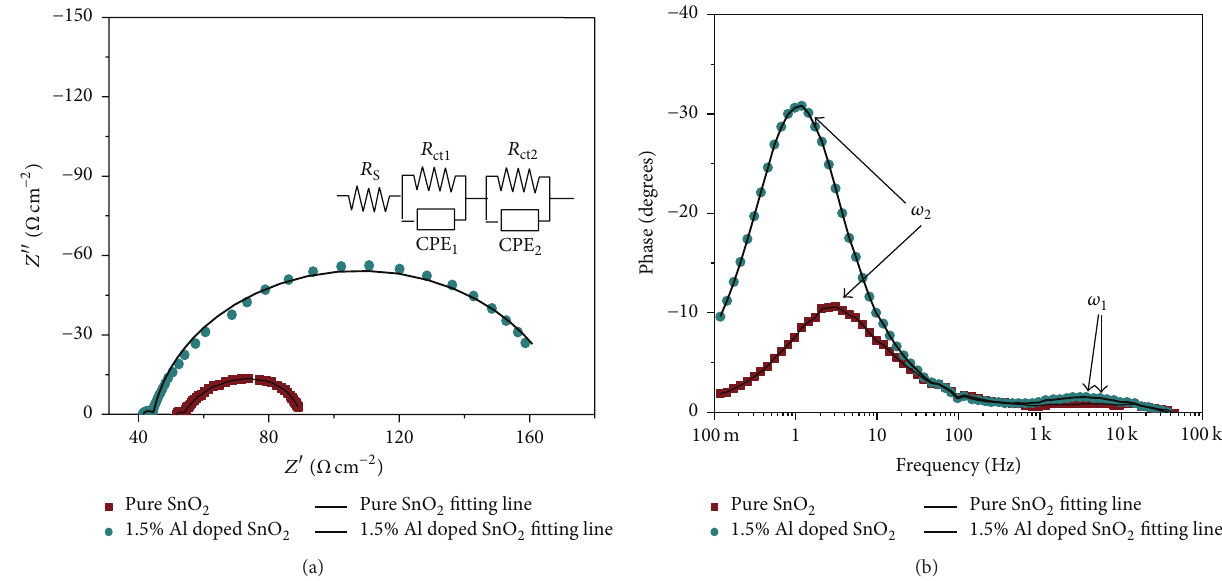
Figure 5: Nyquist plots (a) and Bode phase plots (b) of the DSCs based on the pure SnO 2 and 1.5% Al doped SnO 2 hollow microspheres.